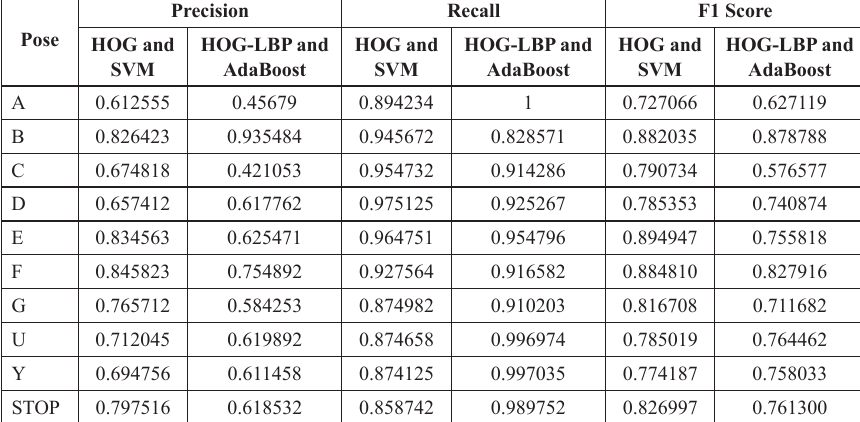
Table 3. Comparison of Precision, Recall and F1 score between our system and system in [34] Precision Recall F1 Score Pose HOG and HOG-LBP and HOG and HOG-LBP and SVM AdaBoost SVM